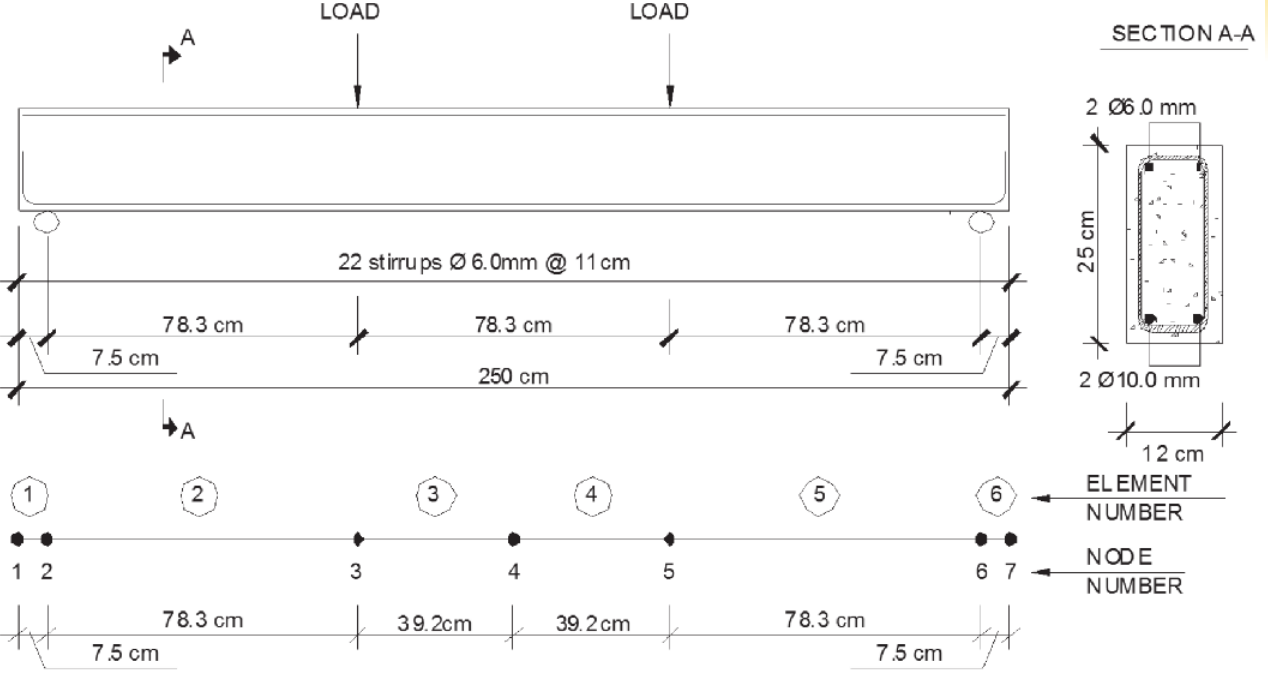
Tested beams (VT1 and VT2) geometry and reinforcement; load application and support positions (Beber [29])